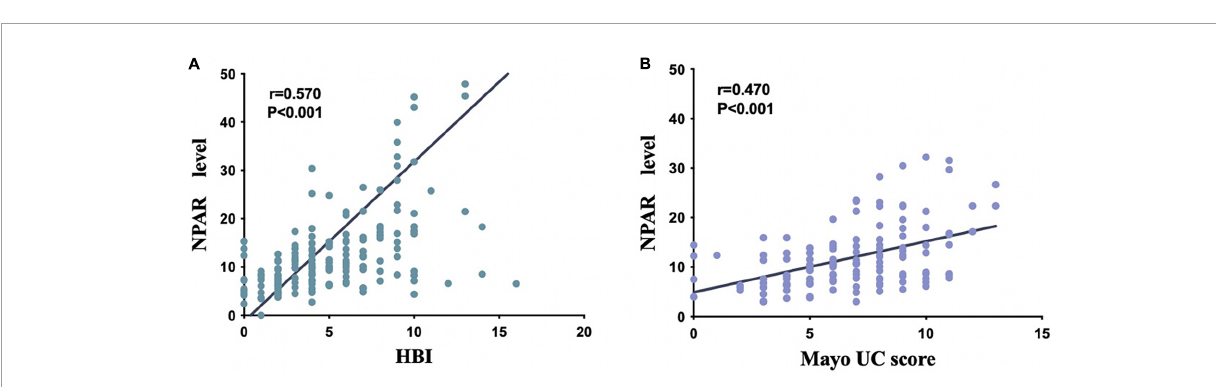
FIGURE5 Scatter plot shows the correlation between NPAR and two clinical scores [Harvey Bradshaw index (HBI) in patients with CD (A) , Mayo score in patients with UC (B)